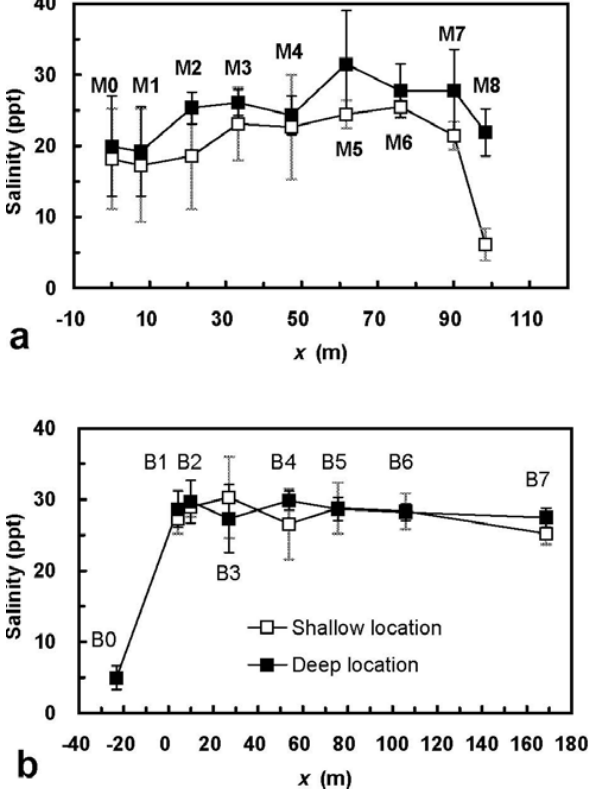
Fig. 6. Observed salinity (ppt) of groundwater over the 3-day observation period in wells along the (a) mangrove and (b) bald beach transects. The intertidal zone is located within 0 m ≤ x ≤ 100 m for the mangrove transect and 0 m ≤ x ≤ 190 m for the bald beach transect, where x is the seaward distance from the high tide mark. Note that most of the observations were made during low tide.